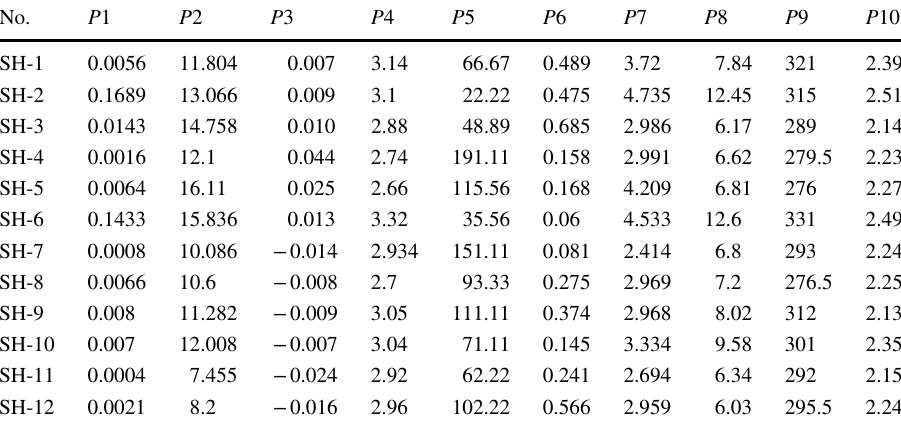
Table 1 Test results of coal samples